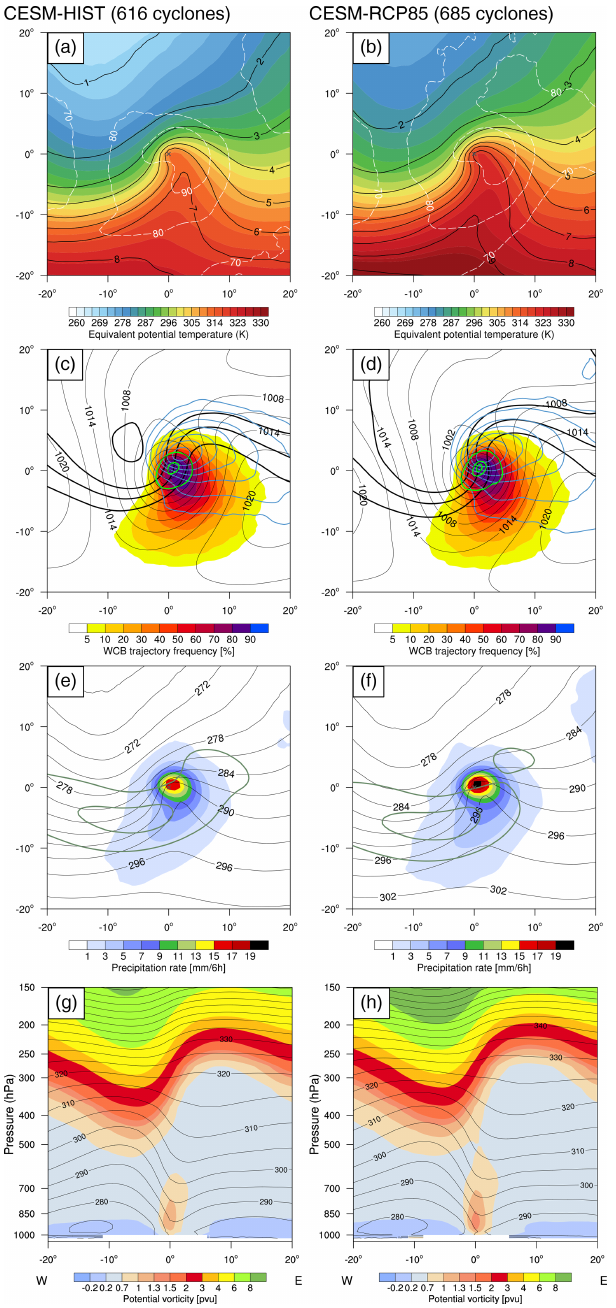
Figure 8. Same as Fig. 7 but for SH